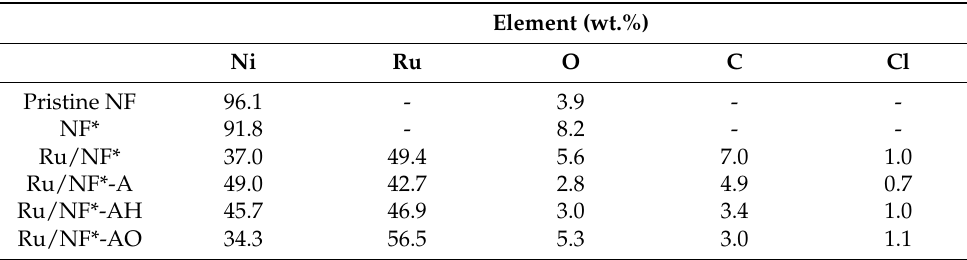
Table 1. Elemental analysis of EDS spectra of pristine NF, NF*, Ru/NF*, Ru/NF*-A, Ru/NF*-AH, and